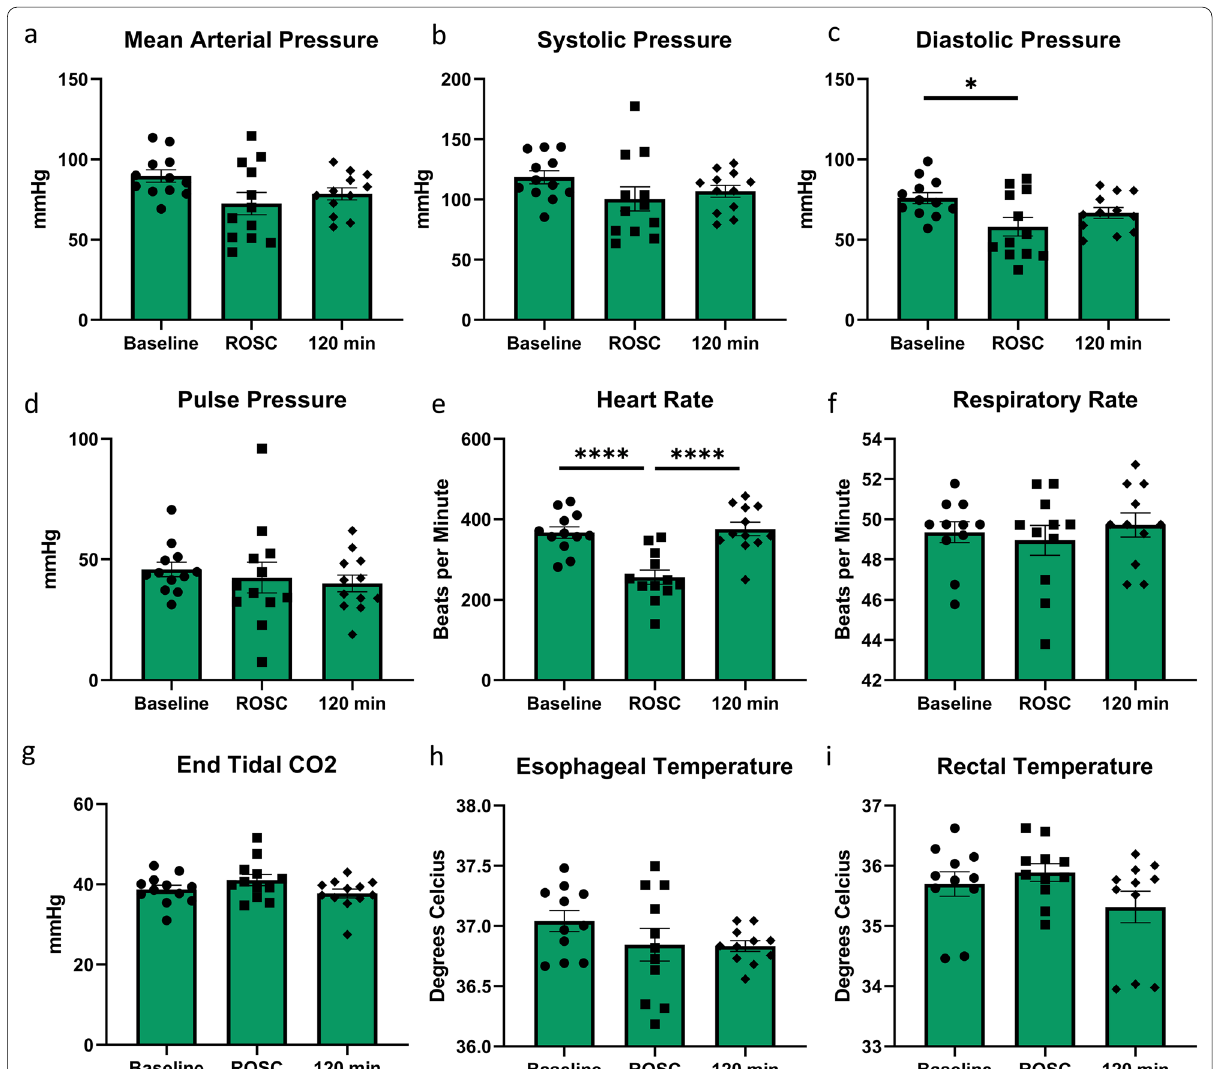
Fig. 2 Physiologic parameter comparison. No major changes in the physiologic parameters (esophageal and rectal temperature, respiratory rate, end-tidal CO 2 , mean arterial pressure, systolic pressure, and pulse pressure) were observed except for the diastolic pressure ( c ) between Baseline and ROSC (P < 0.05) and the heart rate ( e ) between Baseline to ROSC and ROSC to 2 h post-ROSC (P < 0.0001, respectively). Data represented as Mean SEM.*p < 0.05 and ****p < 0.0001; ROSC, return of spontaneous ±